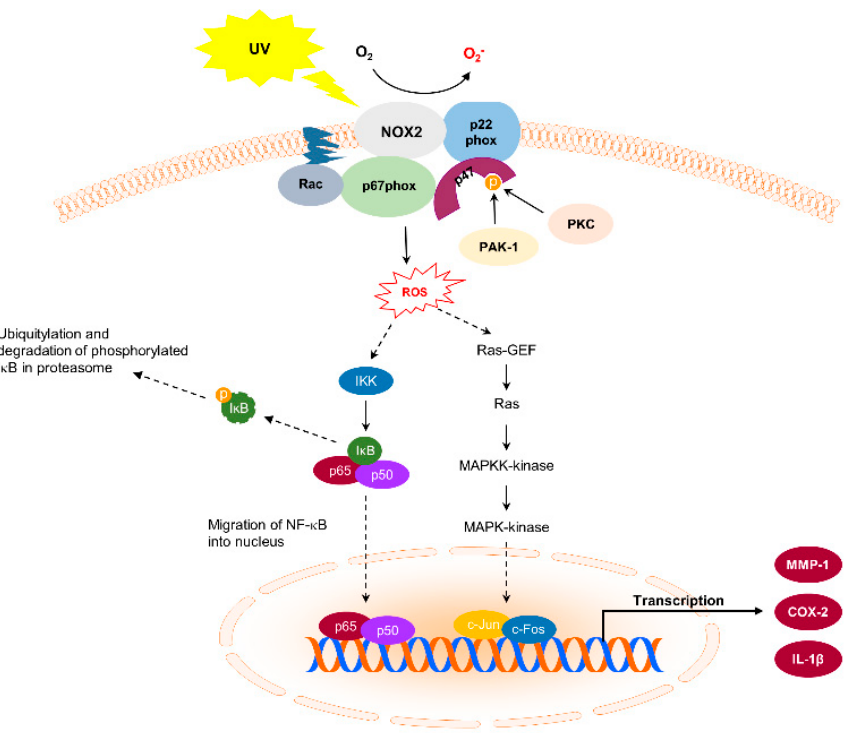
Figure 1. Nicotinamide adenine dinucleotide phosphate oxidase (NOX) and its downstream signaling pathways in ultraviolet (UV)-induced skin carcinogenesis.